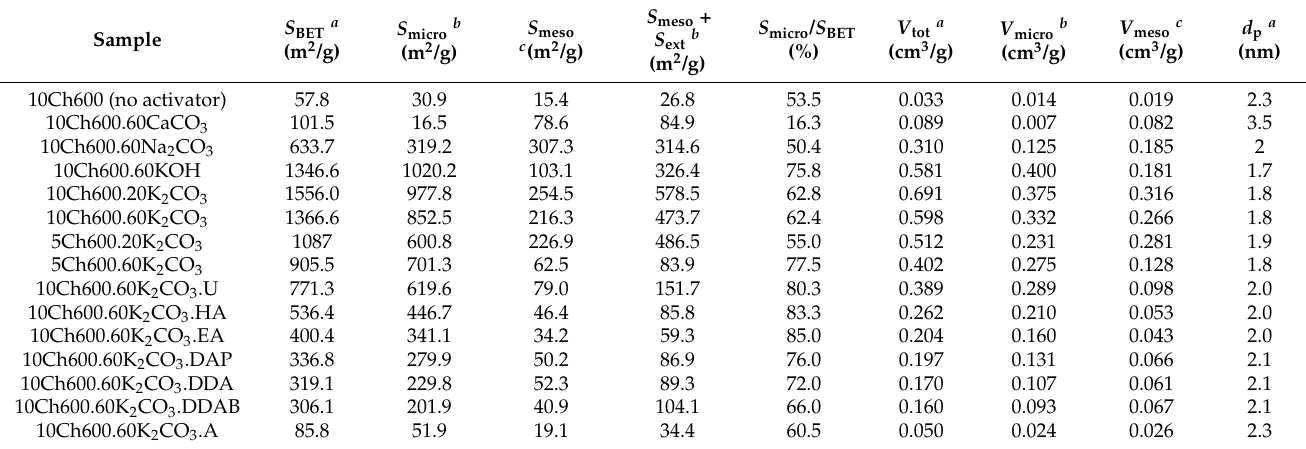
◦ = 0.9956 ( V a BET specific surface area ( S tot ), and adsorption average pore width ( d p ). BET ), total pore volume determined at p/p b Determined using t-Plot method. c BJH adsorption cumulative surface area ( S micro ) and volume ( V meso ) of pores between 2 and 50